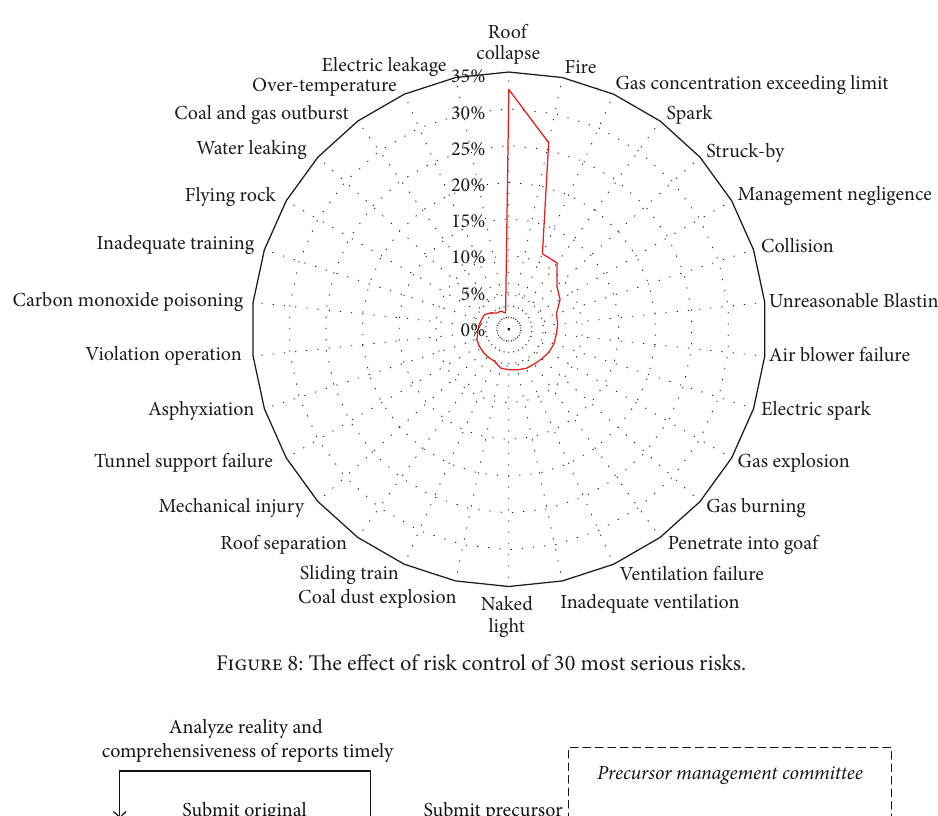
Figure 8: The effect of risk control of 30 most serious risks.